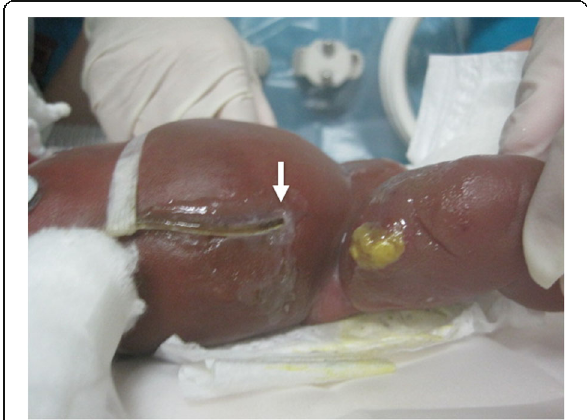
Fig. 3 Application of 2-octylcyanoacrylate (Dermabond®, Ethicon, Inc., Somerville, NJ) around the exit site of the tube was effective for stopping pericatheter leakage in PD. The arrow indicates the site of tube